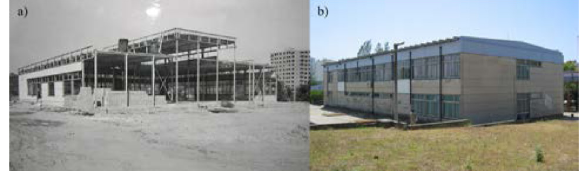
Fig. 4. Secondary school from sub-typology D: a) Pavilion construction using CLASP system, (Sorefame Portugal); b) View from the exterior of